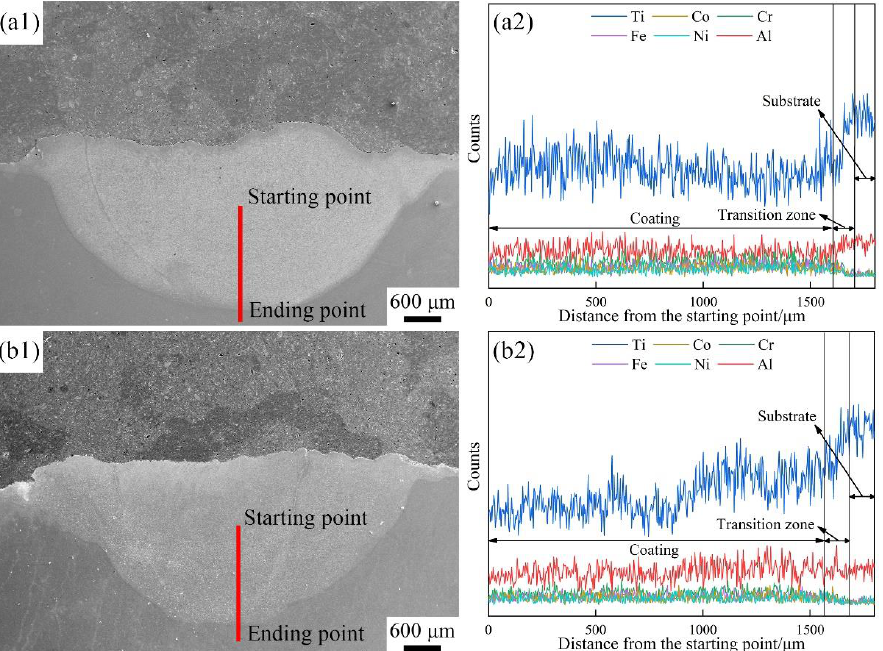
Figure 3. The cross-sectional macromorphologies and the elemental distribution along the depth direction of the coatings: ( a1 , a2 ) without Al; ( b1 , b2 ) with Al.